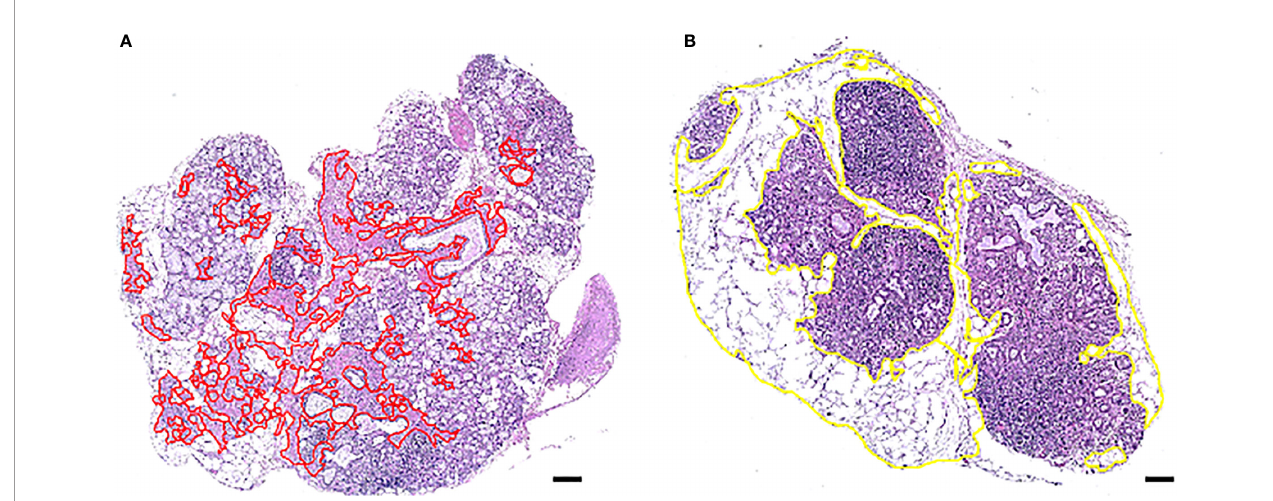
FIGURE 1 | Morphometric distinction of atrophy and adipose tissue in one MSG from two patients with pSS. One representative salivary gland from each patient biopsy, using AperioImage Scope©, are shown. Atrophy and adipose tissue were quanti fi ed as a percentage of the total MSG parenchymal area. Parenchymal atrophy in the MSG biopsy of patient (A) was 9.1% and parenchymal adipose in fi ltration in patient (B) was 49,4%, where both possessed marked levels. Scale bar = 0.5